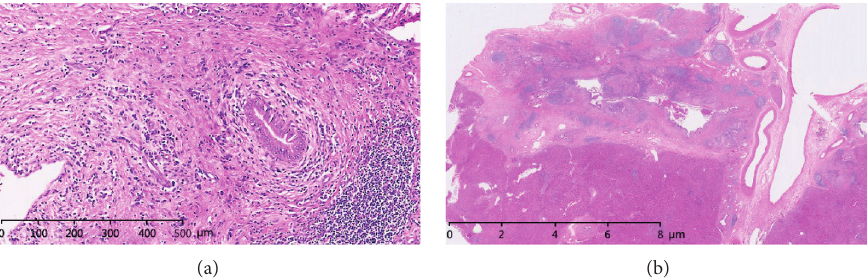
Figure 4: (a) Liver biopsy revealing portal infiltration of lymphocytes, plasmacytes, and scattered eosinophils with fibrosis and pseudolobule (H&E, 10 × 10). (b) Histological examination demonstrating neutrophilic microabscesses in the crypts (H&E, 10 ×